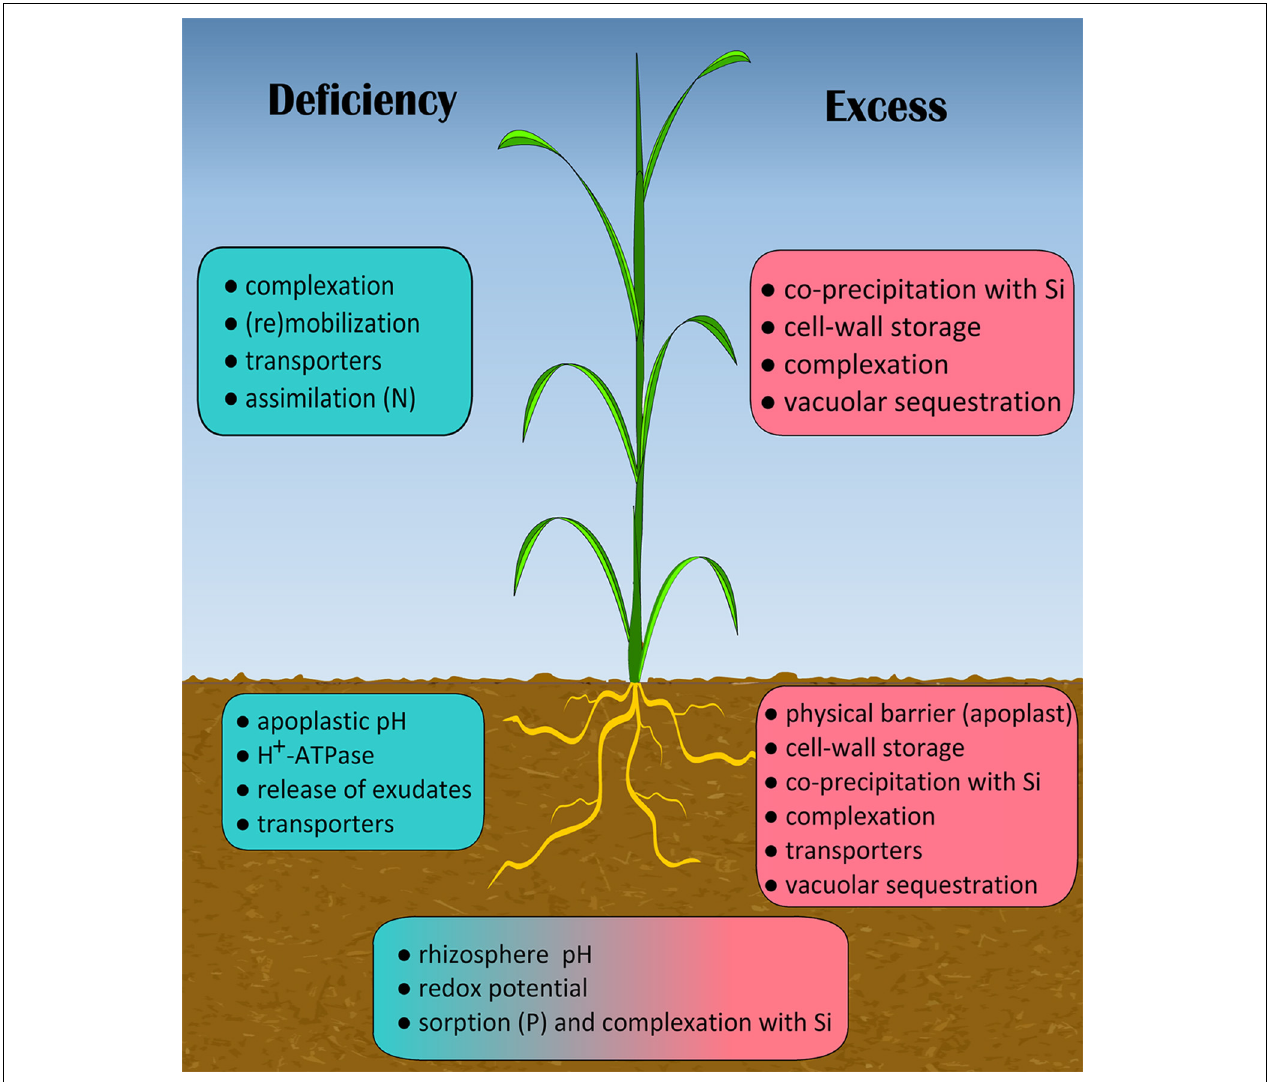
FIGURE 2 | Processes directly involved in rhizosphere mobilization, root uptake, root-to-shot transport and shoot utilization of essential (nutrients) and beneficial elements modulated by Si. Left (blue), nutrient deficiency; right (pink), excess of nutrients and beneficial elements; middle (blue/pink), nutrient deficiency or excess of nutrients and beneficial elements. General ameliorating effect of Si in stressed plants (e.g., increased tissue antioxidant capacity) may also improve overall plant performance thereby enhancing the above-mentioned